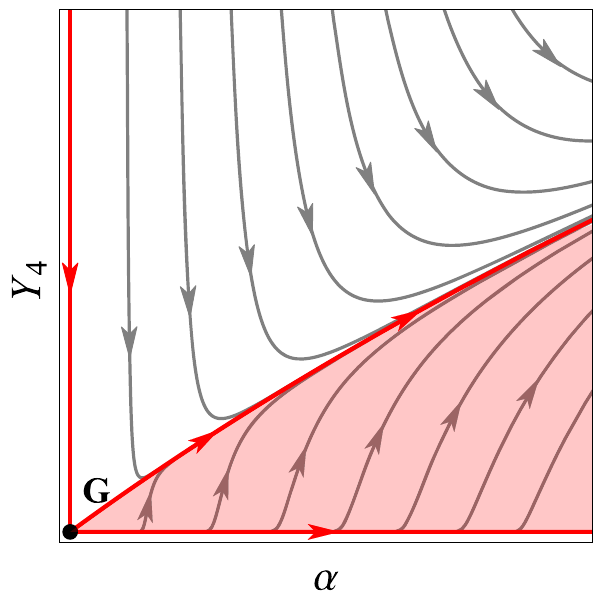
Fig. 2 Phase diagram of gauge–Yukawa theories with B > 0 and C < 0 at weak coupling showing asymptotic freedom and the Gaussian UV fixed point ( G ). Arrows indicate the flow towards the IR. The red- shaded area covers the set of UV complete trajectories emanating form the Gaussian UV fixed point. The Yukawa nullcline acts on trajectories as an IR